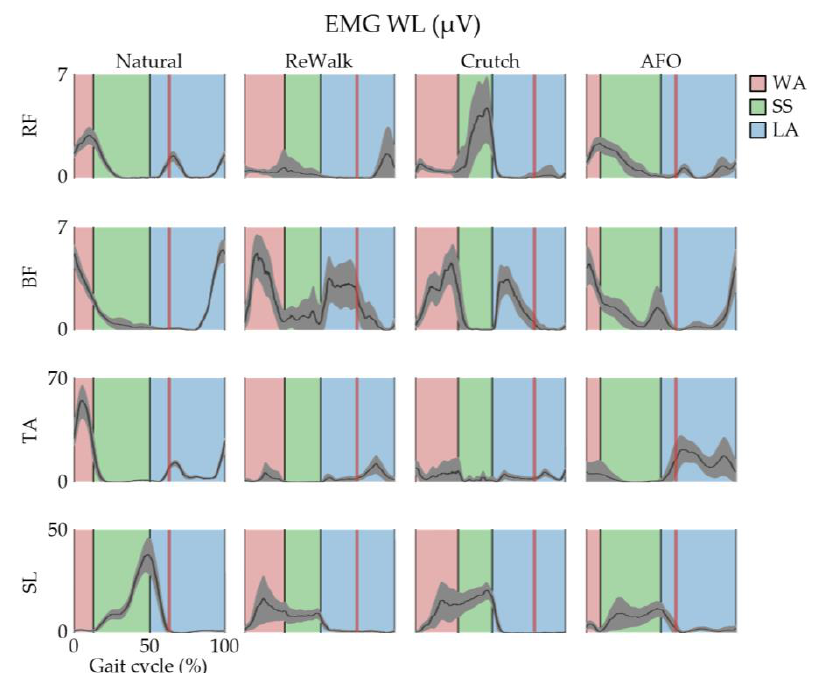
Figure 2. Lower-limb EMG patterns within the gait cycle obtained during the gait sessions performed by subject 1. The gait cycle is further divided into three biomechanical task-related phases, where red, green, and blue stages represent the WA, SS, and LA phases, respectively. The red vertical line represents the ipsilateral foot’s LO position. The data are represented as mean ± SD via black lines and grey areas,